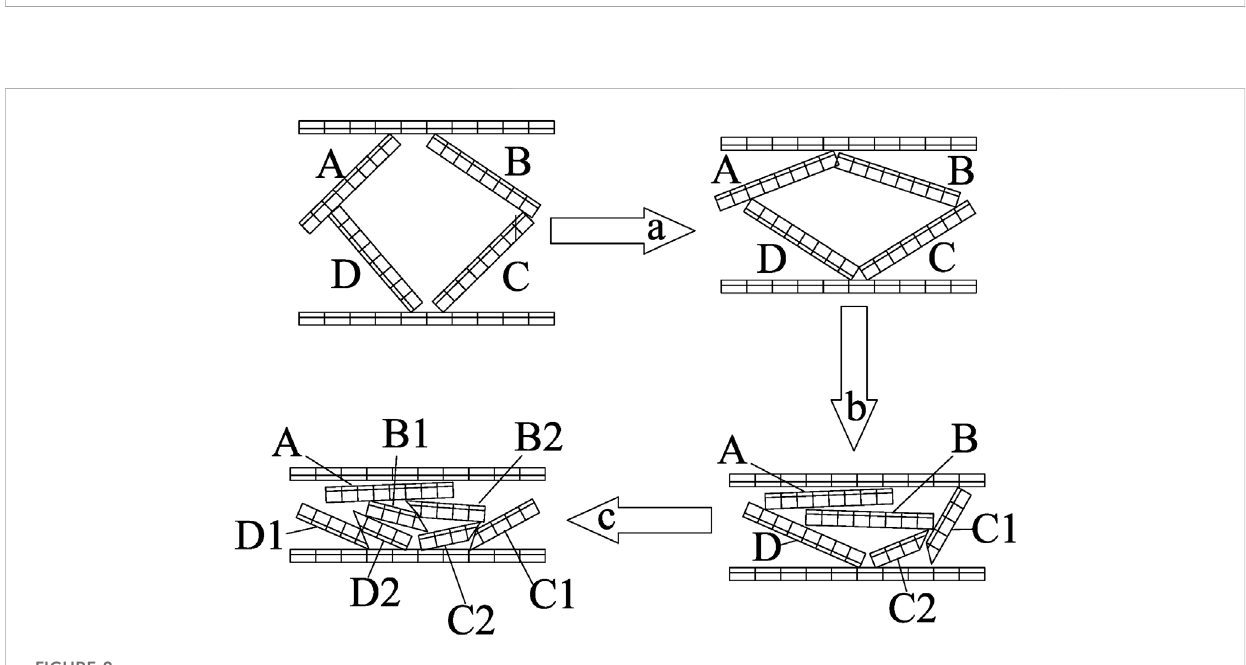
FIGURE 8 Deformation process of soil